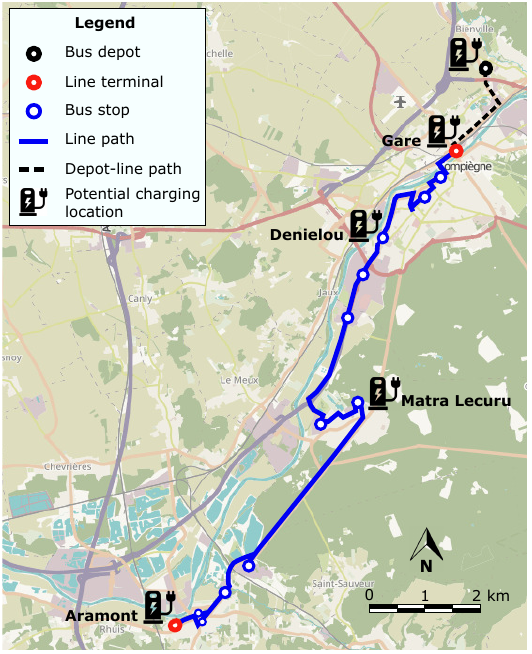
Figure 6. Bus line ARC EXPRESS in Compiègne